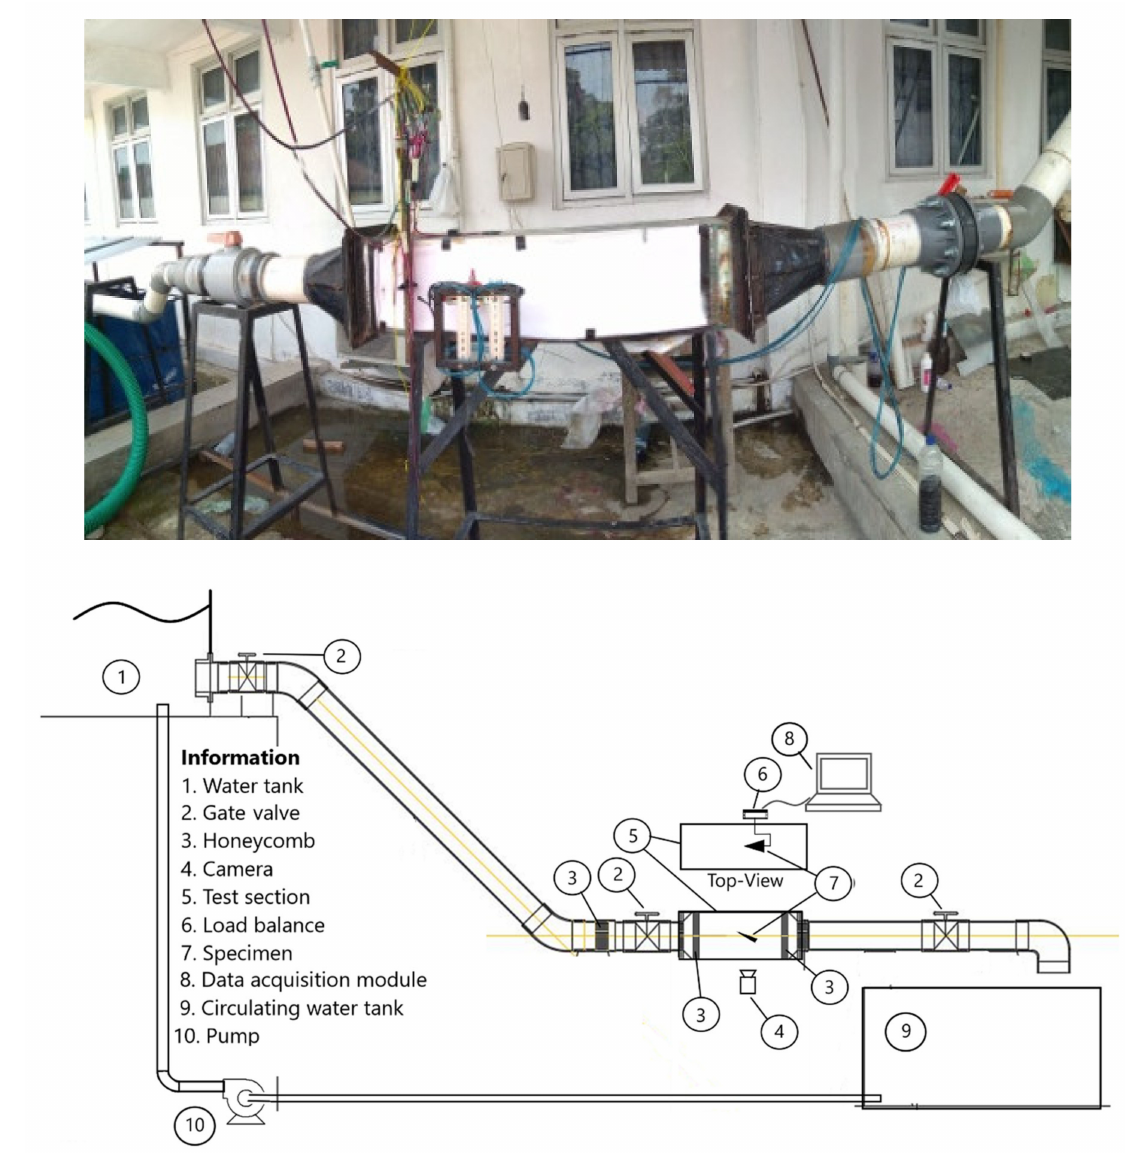
Figure 2. GAMA water tunnel test